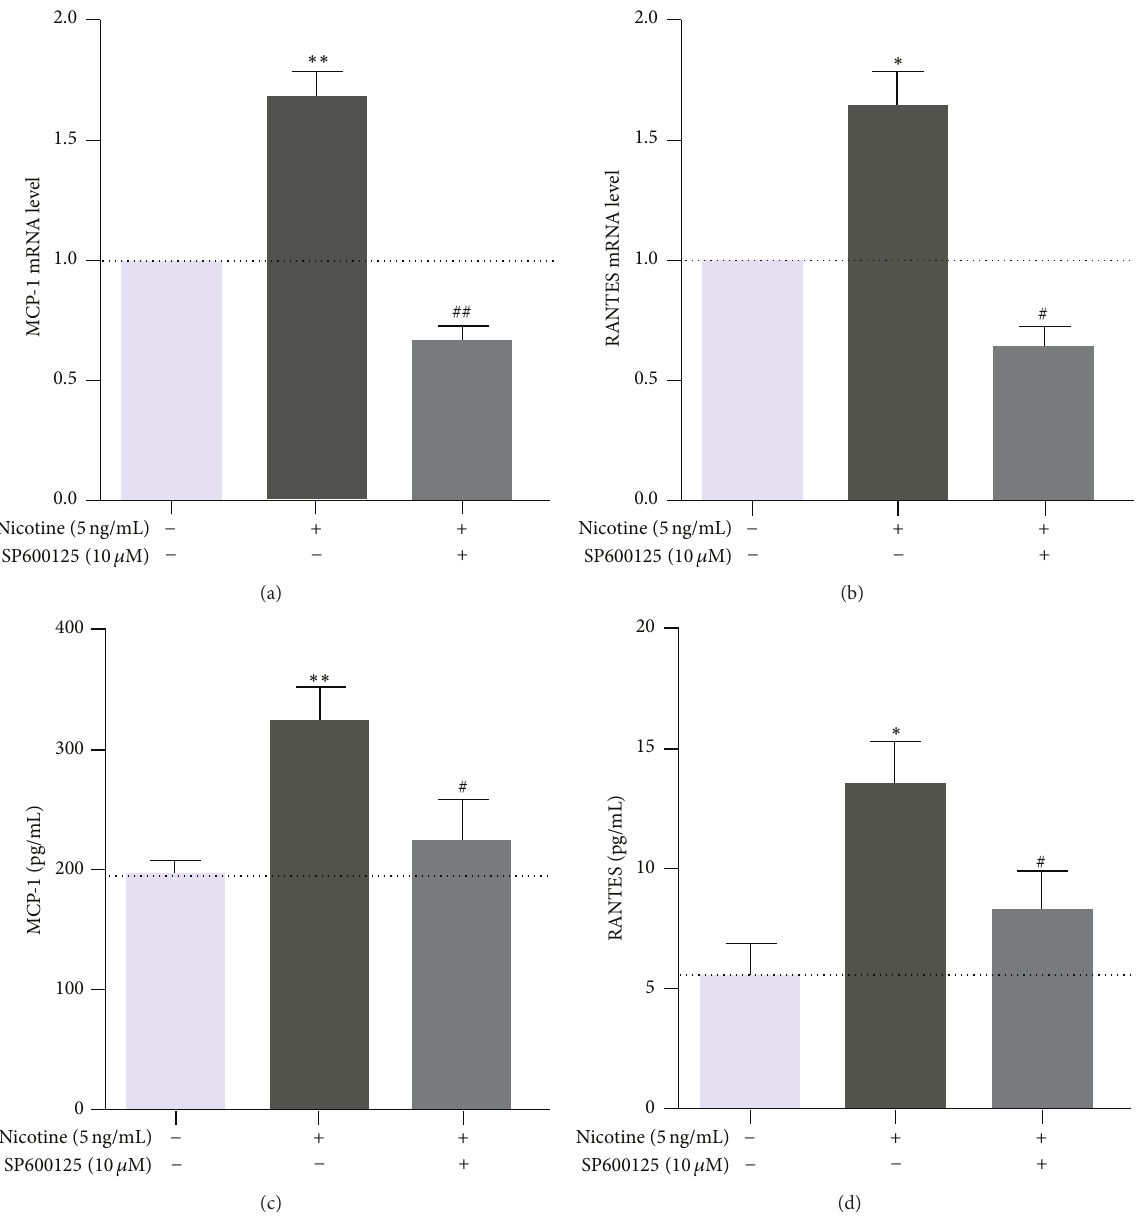
Figure 6: Influence of SP600125 on nicotine-induced expression of MCP-1 and RANTES in MOVAS cells. Cellular mRNA expression levels of MCP-1 and RANTES (a, b) and the levels of secreted MCP-1 and RANTES in the supernatant (c, d) are shown. Nicotine at 5 ng/mL could significantly upregulate the cellular mRNA expression as well as secretion of MCP-1 and RANTES, while SP600125 eliminated this effect. Data are from independent triplicate experiments. ∗ 𝑃 < 0.05 and ∗∗ 𝑃 < 0.01 versus control; # 𝑃 < 0.05 and ## 𝑃 < 0.01 versus the group treated with 5 ng/mL